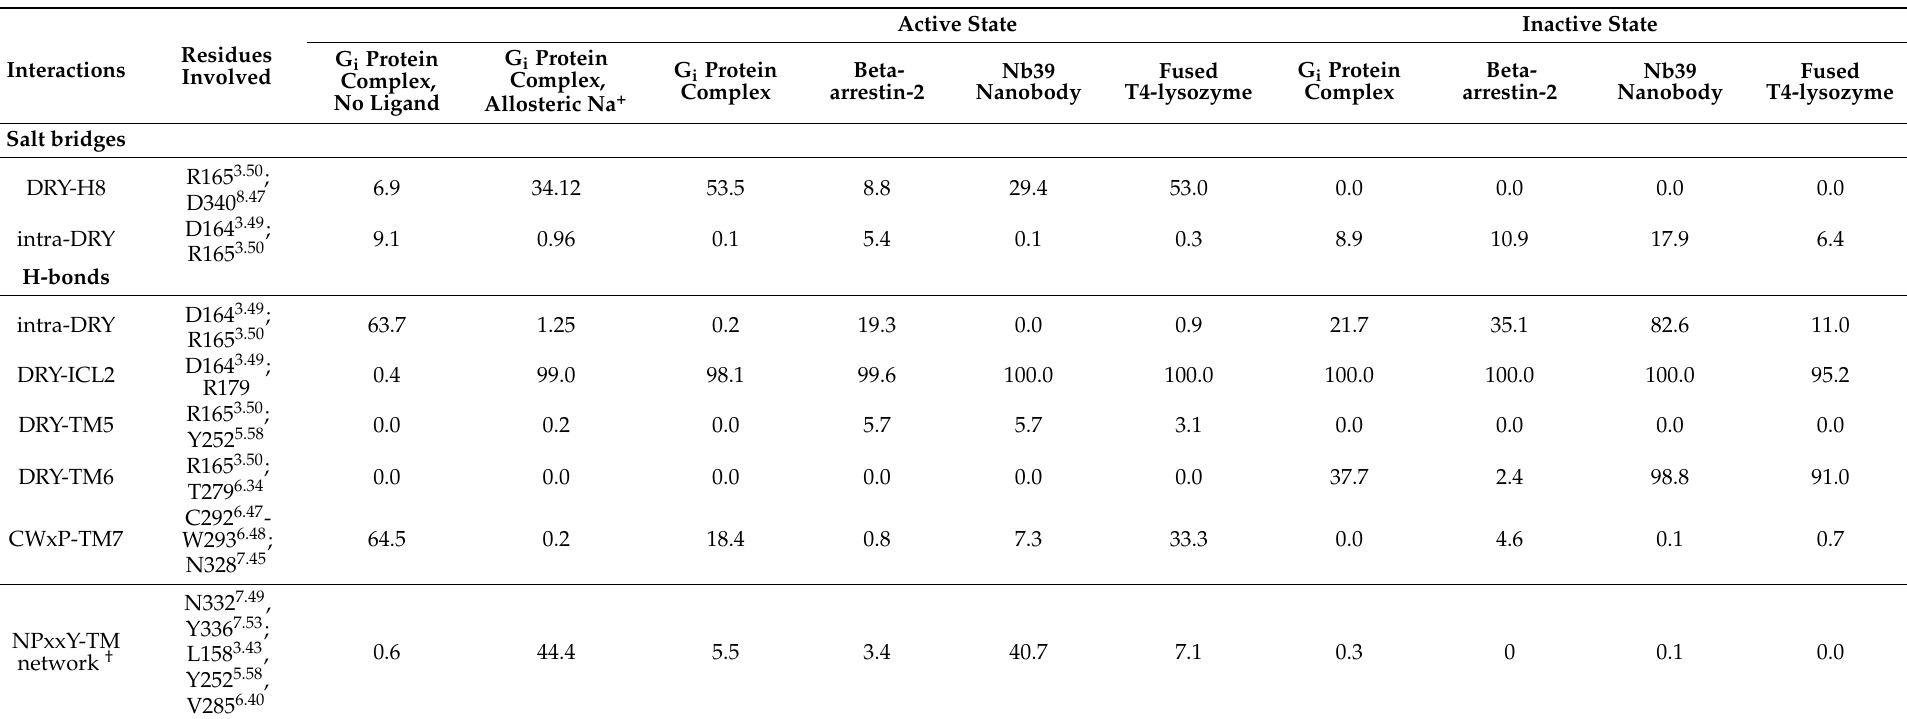
Table 1. Frequency of intramolecular salt bridges and H-bonds expressed as percentages of the total conformational ensemble, generated by MD simulations.